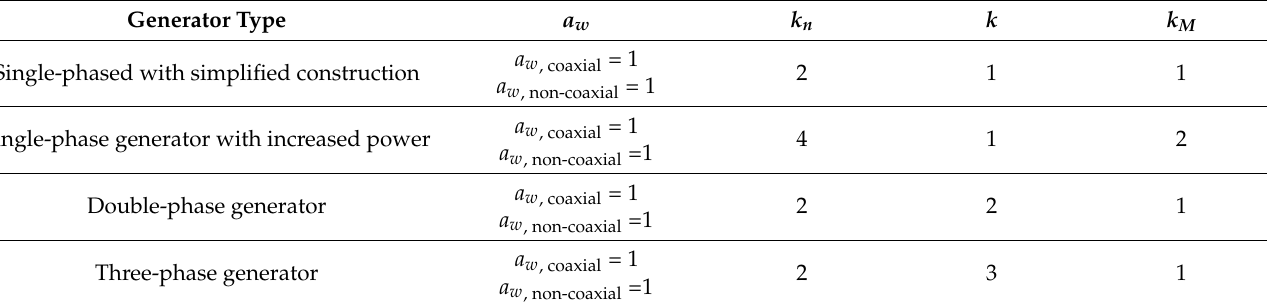
Table 1. Parameters of coefficients for mathematical